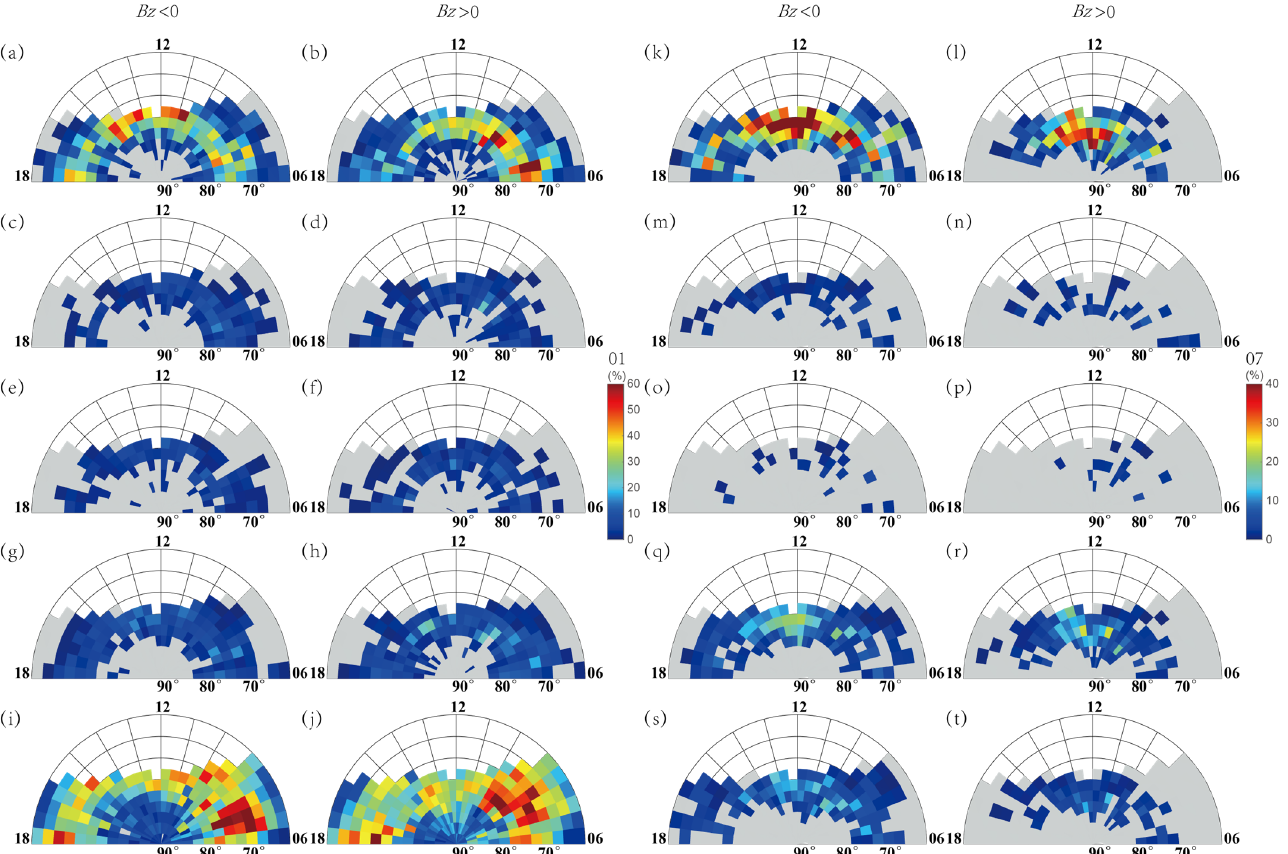
Figure 7. Temporal–spatial distribution of different types of ion upflows under different direction of IMF Bz . From top to bottom are ion upflows of type A to E, respectively. ( a – j ) statistics for January, ( k – t ) statistics for July.